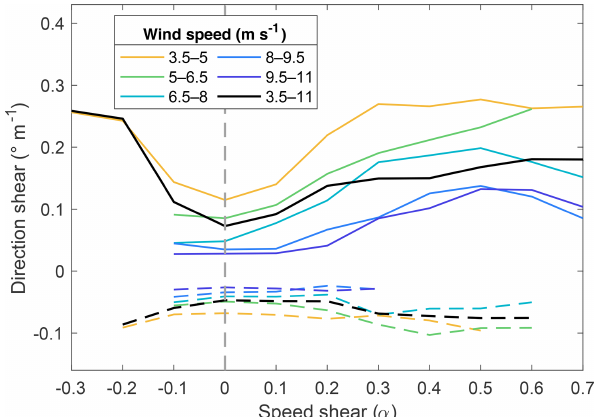
Figure 13. Mean speed and direction shear relationship for similar hub-height wind speed regimes (1.5ms − 1 bins). Solid lines cor- respond to wind veering and dashed lines to wind backing. Black lines correspond to the mean for all wind speeds. The dashed grey line marks the zero-speed shear value.